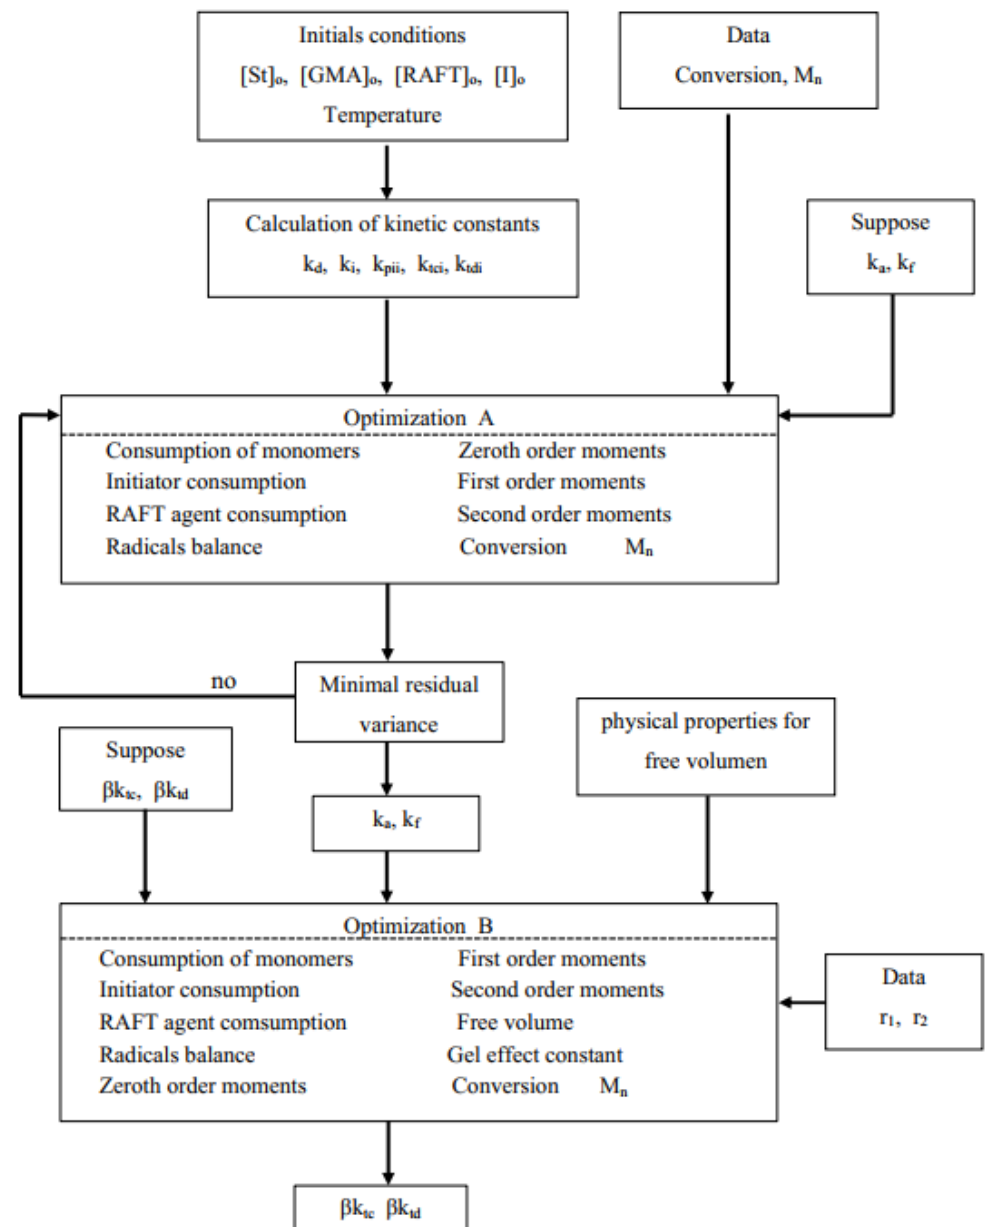
Figure 1. Flow chart for the estimation of kinetic and AA effect parameters.